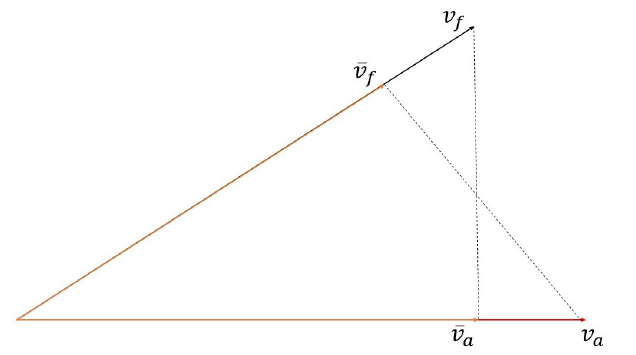
Figure 3. Two-dimensional progress of projection function. v a is the feature vector extracted by A-Net, and v f is the feature vector extracted by F-Net. v f is the new feature vector that v f projected to v a , and v a is the new feature vector that v a projected to v f